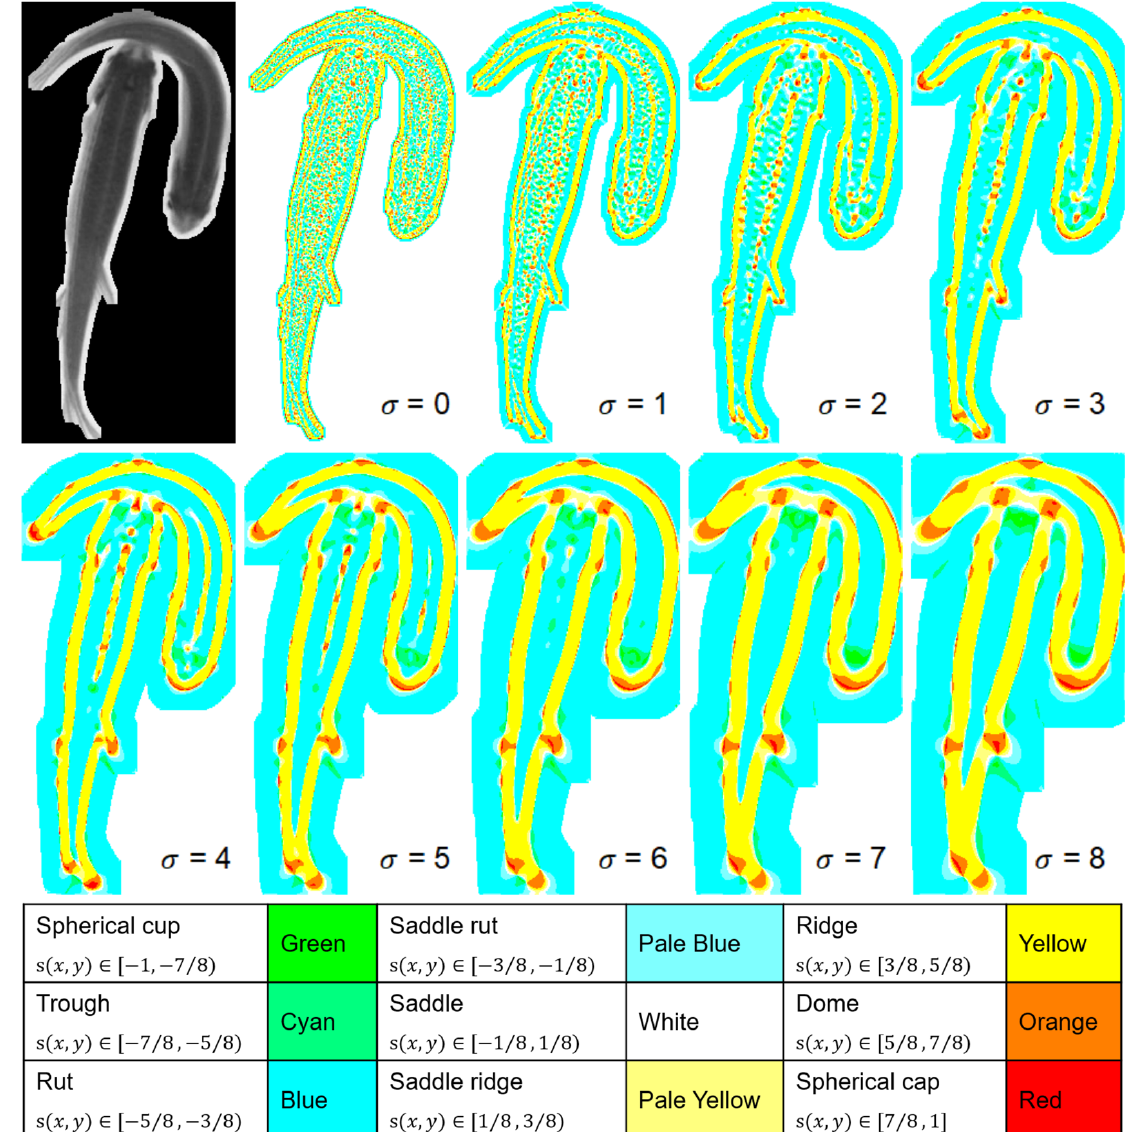
Figure 3. Shape index results image produced by Gaussian kernels with different σ values and the definition of shape index categories.